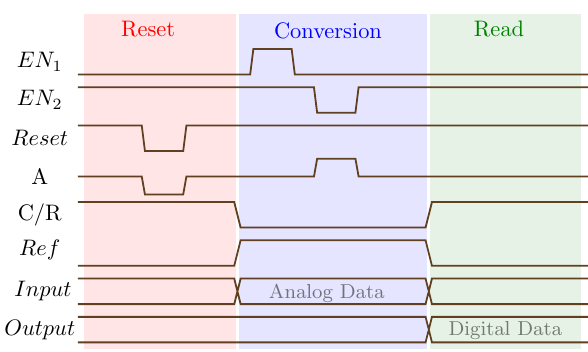
Figure 13. ADC proposed in Reference [67].